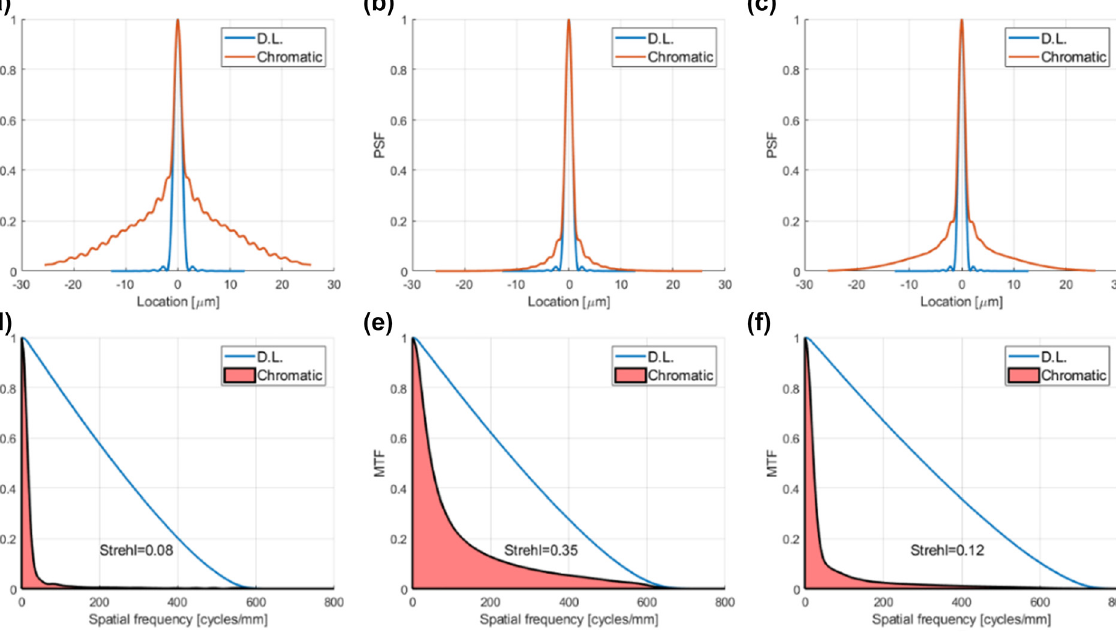
Figure 6: PSFs and MTFs of conventional diffractive lens over RGB spectral ranges, defined according to spectral response given in [47], with lower and upper cutoffs at 450 nm and 650 nm respectively (a) R PSF cross section (b) G PSF cross section (c) B PSF cross section (d) R MTF (e) G MTF (f) B